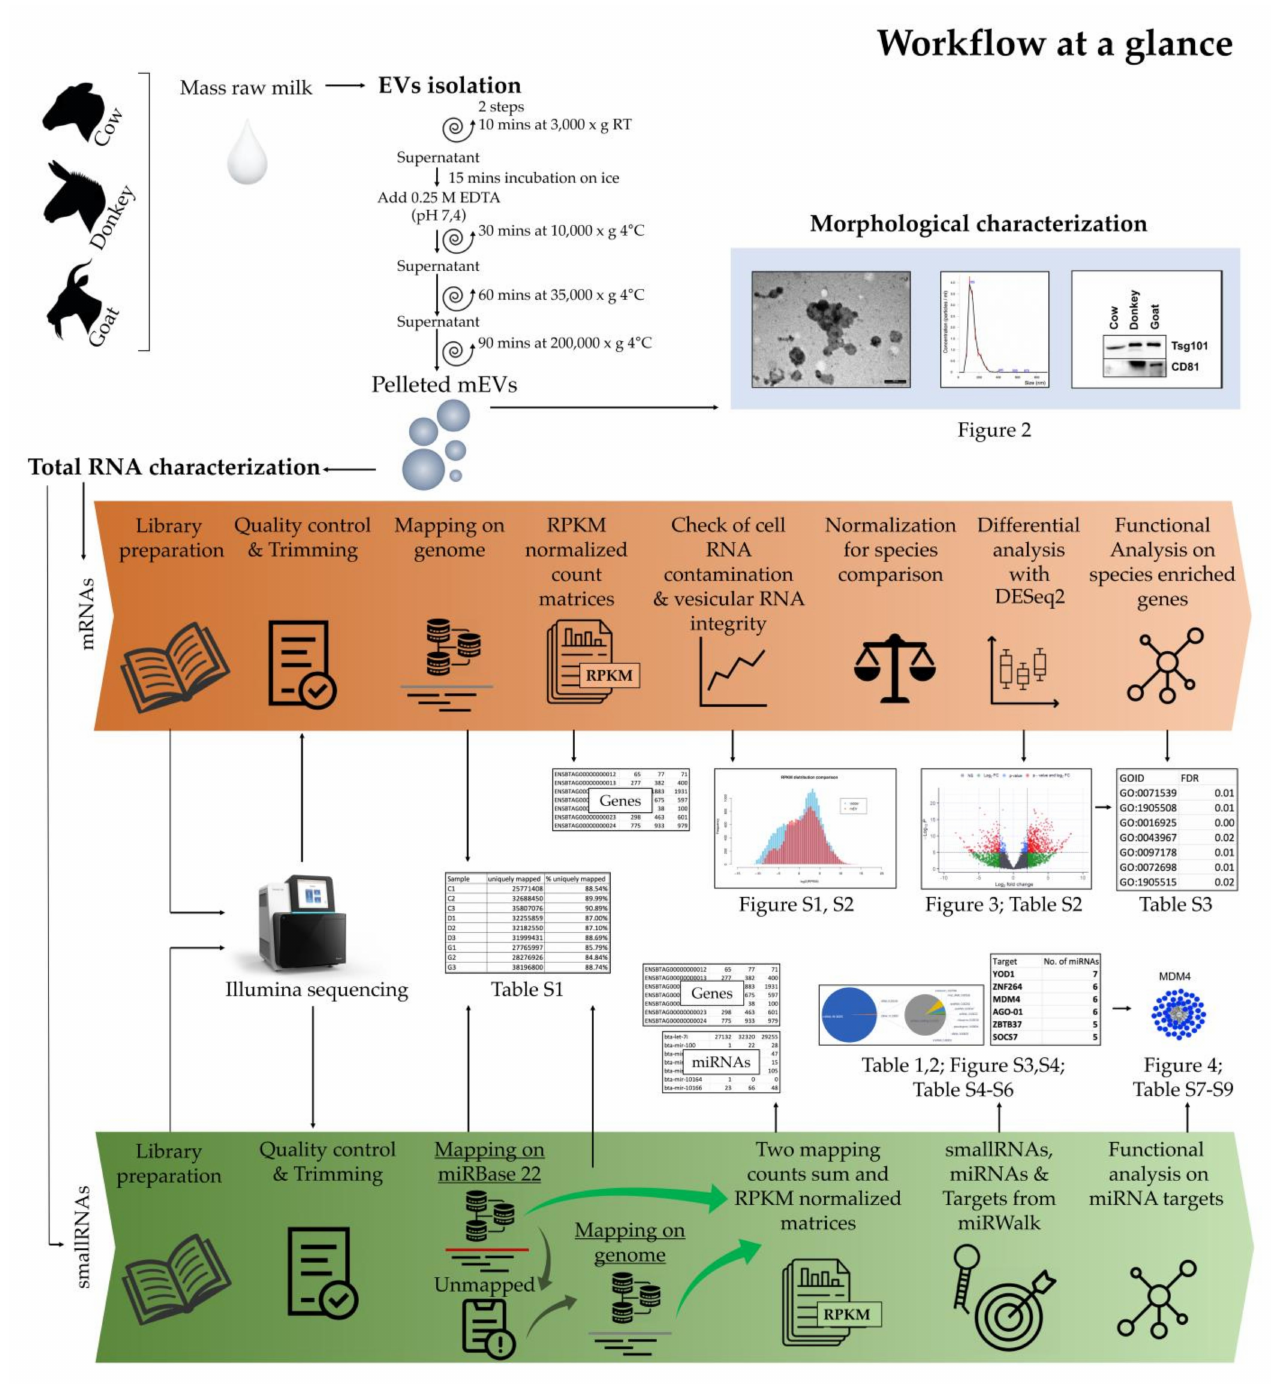
Figure 1. Workflow overview